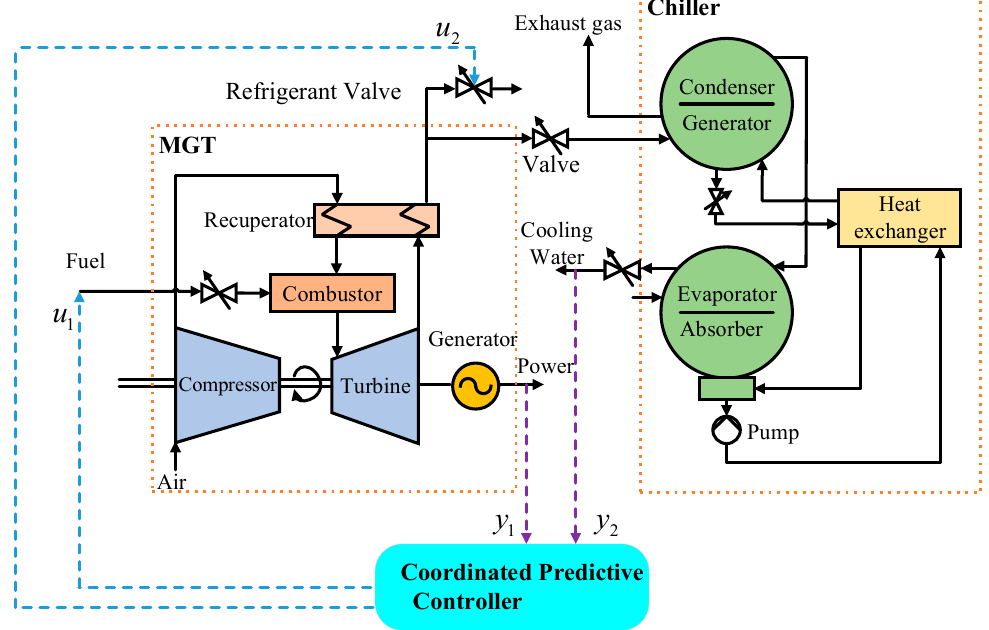
Figure 1. The MGT-CCP system schematic diagram.